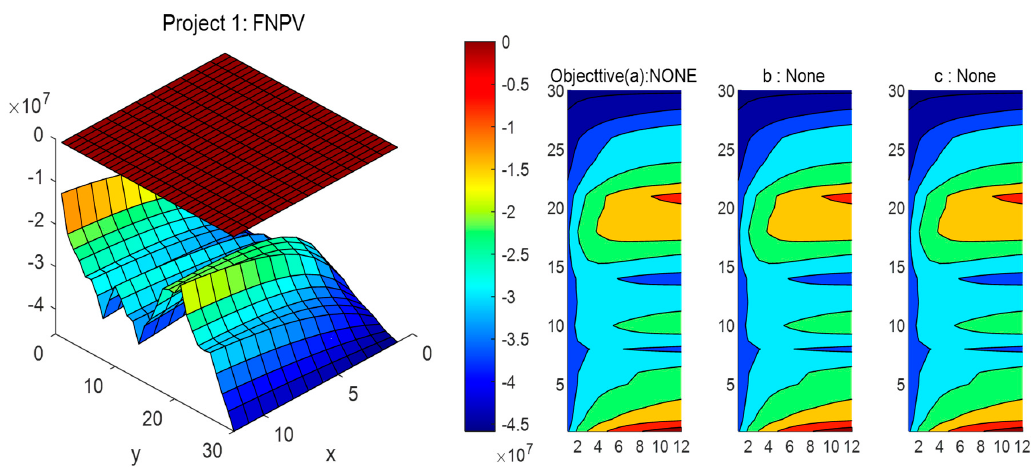
Figure A4. Decision − making for project 1.